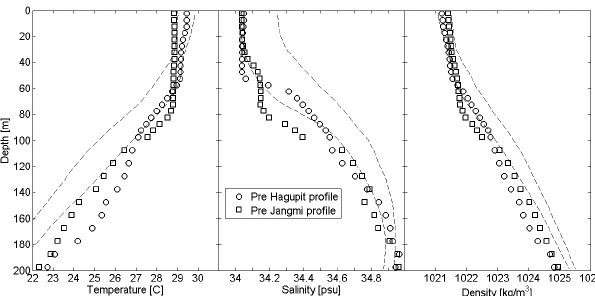
Figure 6. The initial temperature [ ◦ C], salinity [psu], and density [kgm − 3 ] profiles used in the 3DPWP simulations HH and HJ (cir- Fig. 6. The initial temperature [C], salinity [psu], and density [kg/m 3 ] profiles used in the 3 cles) and JJ (squares) described in the text. The dashed black lines 3DPWP simulations HH and HJ (circles) and JJ (squares) described in the text. The dashed 4 show the mean climatology profiles with added and subtracted stan- black lines show the mean climatology profiles with added and subtracted standard deviations 5 dard deviations for September 2008. for September, 2008. 6